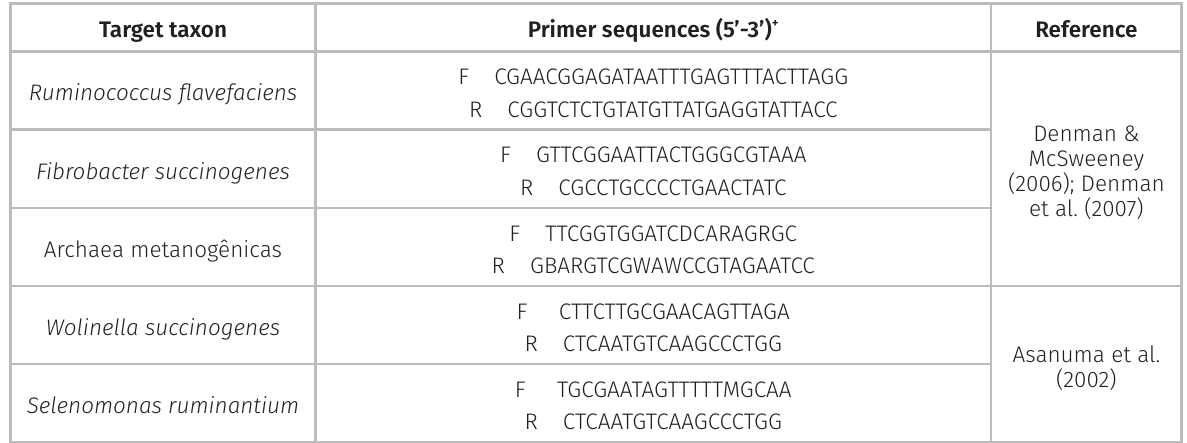
Table II. PCR primers used in this